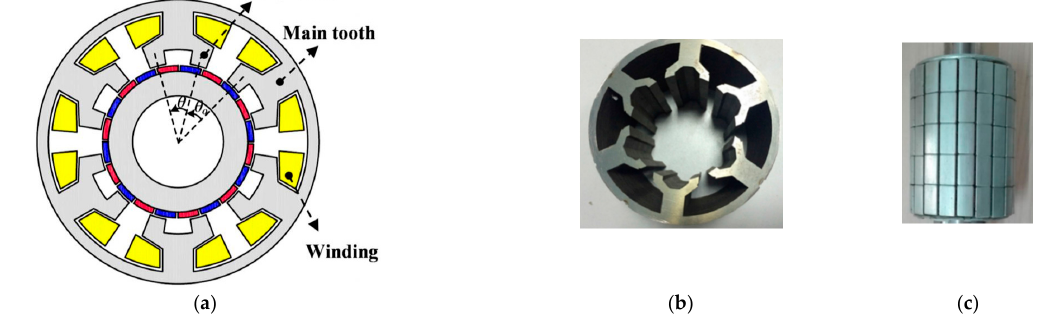
Figure 5. Split-tooth SVPM machine: ( a ) Machine configuration; ( b ) Stator core; ( c ) PM rotor [19].